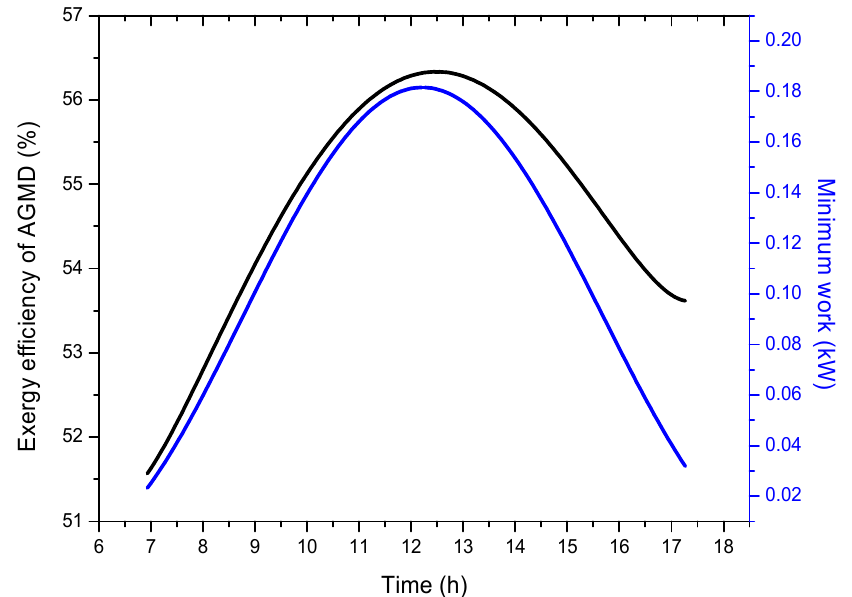
Figure 10. Variation of exergy efficiency of AGMD andthe minimum separation work with time.